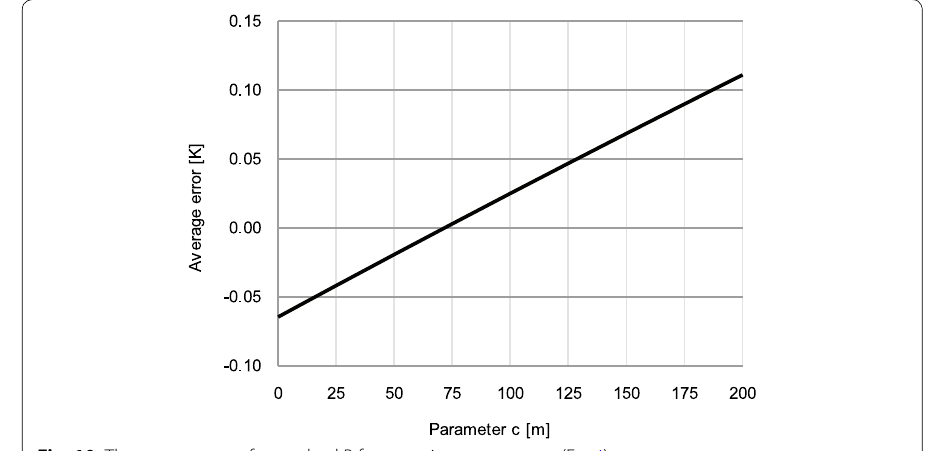
Fig. 10 The average error for method B for a varying parameter c (Eq.